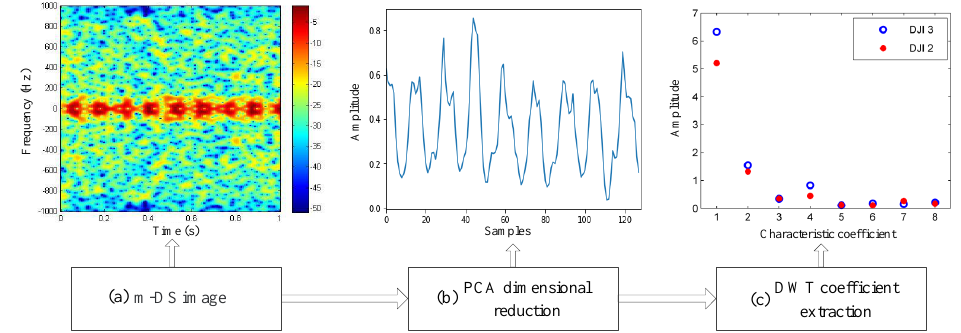
Figure 8. Combined PCA-DWT feature extraction flow